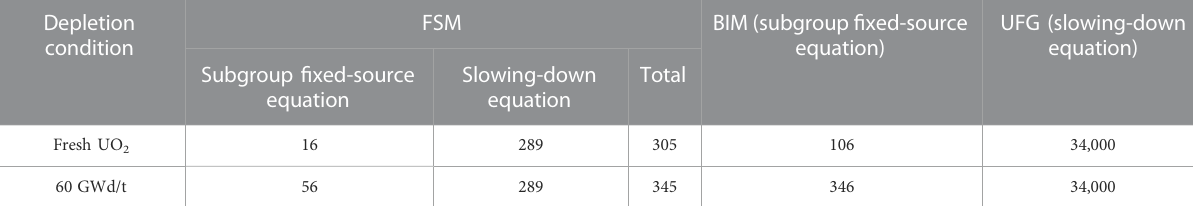
TABLE 12 Calculation burden for different resonance treatment methods. Depletion